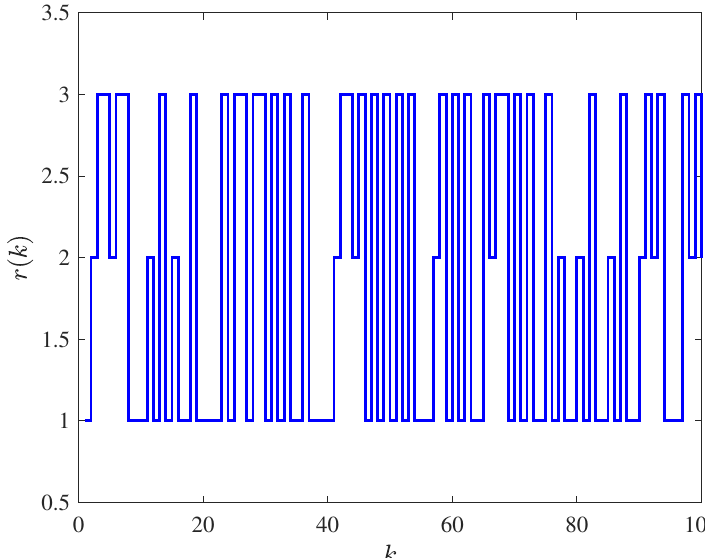
Figure 7. Evolution of r ( k ) in Case 3.